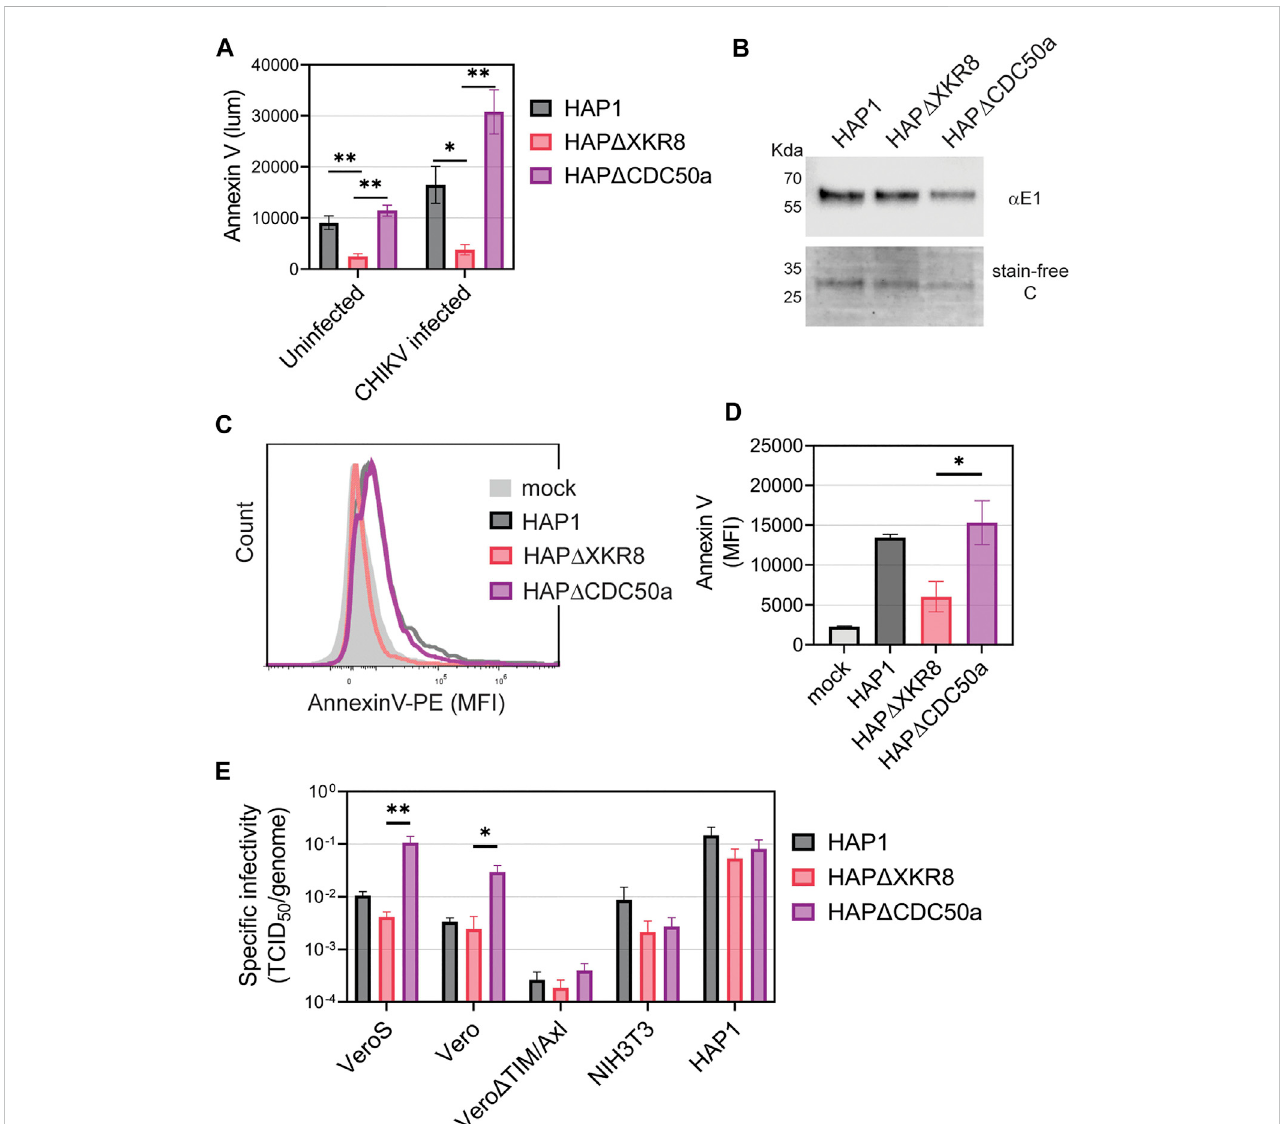
FIGURE 5 CHIKV virion PS levels correlate with speci fi c infectivity in Vero cells. (A) HAP1 cell lines were monitored for Annexin V binding (luminescence) at 24 h using a GloMax Explorer microplate reader. Parental, Δ XKR8, and Δ CDC50a cells were either untreated or infected with CHIKV (strain 181/c25, MOI 1). (B) CHIKV waspropagated in HAP1 cells and HAP1 cell lines knockedout for scramblases ( Δ XKR8) and fl ippase subunits ( Δ CDC50a). Particles were normalized to genomeequivalentsandexaminedwithimmunoblotusingaCHIKVE1antibodyandassessedforpurityusingastain-freegel. (C,D) AnnexinVconjugated to PE was used to stain normalized amounts of virus-bound beads and quanti fi ed via fl ow cytometry. A bead-only control (mock) was used to establish a baseline signal. MFI values from three independent trials were normalized to parental values (HAP1) with the mean and ±SEM displayed. An unpaired parametric t -test with Welch ’ s correction was used test for statistical signi fi cance between Δ XKR8 and Δ CDC50a conditions. (E) The ratio of TCID 50 to genome copy equivalents for each sample was used to assess the infectivity of particles produced from HAP1 cell lines on a panel of commonly used mammalian cell lines (monkey Vero, mouse NIH3T3, and human HAP1). Data are presented as the mean ± SEM from three independent experiments performed in duplicate or triplicates. Infectivity values were natural log (ln) transformed before performing an unpaired parametric Student ’ s t-test between Δ XKR8 and Δ CDC50a conditions. *, p < .05; **, p <